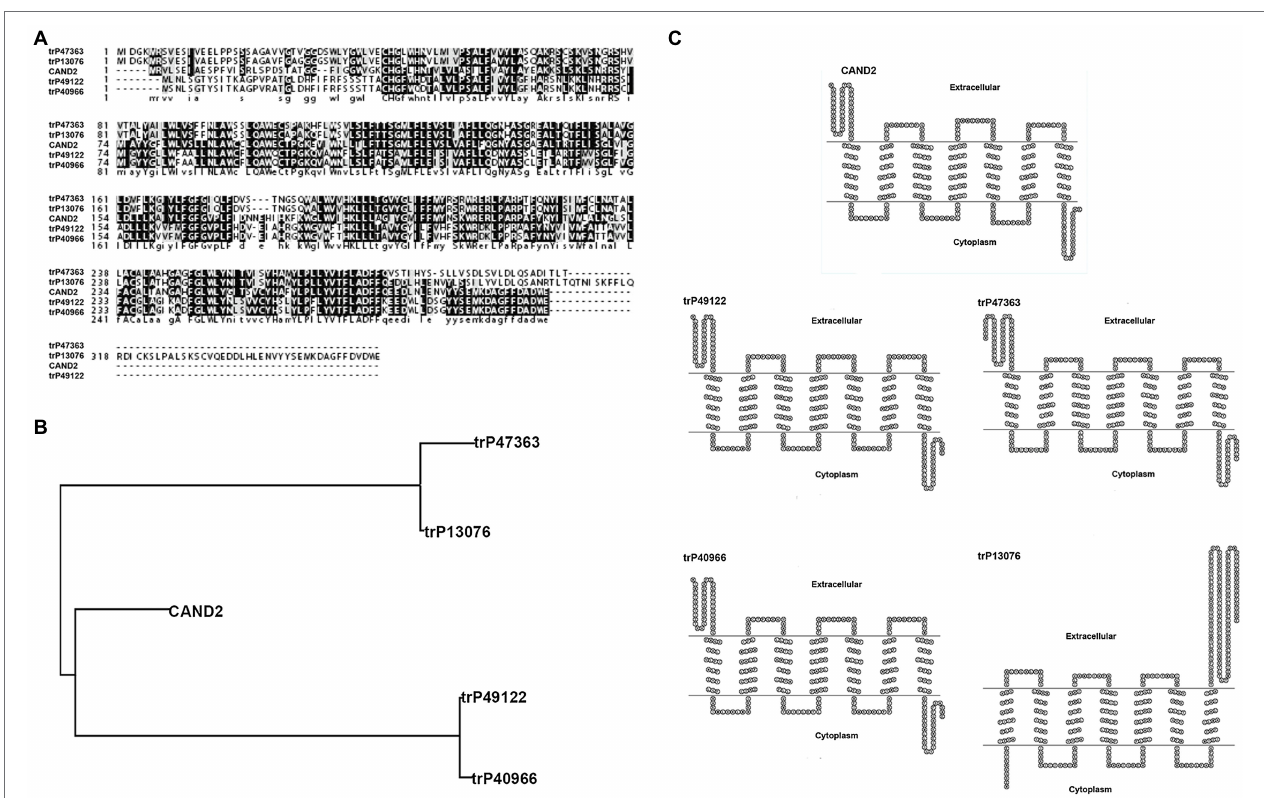
FIGURE 6 | Bioinformatic prediction of four membrane receptors potentially involved in binding melatonin in N. benthamiana . Bioinformatic prediction and analysis of four putative transmembrane MT-receptor proteins in N. benthamiana. (A) Multiple sequence alignment of the known MT receptor in Arabidopsis (CAND2/ PMTR1) with the putative MT-transmembrane receptors, trP47363, trP13076, trP49122, and trP40966 in N. benthamiana . Alignments were carried out using CLUSTAL (http://clustalw.genome.jp). Identical and similar amino acids are indicated by dark and light shading, respectively. (B) Evolutionary relationships between the known MT receptor (CAND2/PMTR1) in Arabidopsis and the putative MT receptors (trP47363, trP13076, trP49122, and trP40966) in N. benthamiana. The evolutionary history was inferred using the Neighbor-Joining method within the MEGA7 program. (C) The predicted transmembrane structure of CAND2 and trP47363, trP13076, trP49122, and trP40966 as determined using HMMTOP software (http://www.sacs.ucsf.edu/cgi-bin/hmmtop.py). The bold, underlined amino acid sequence indicates the putative transmembrane